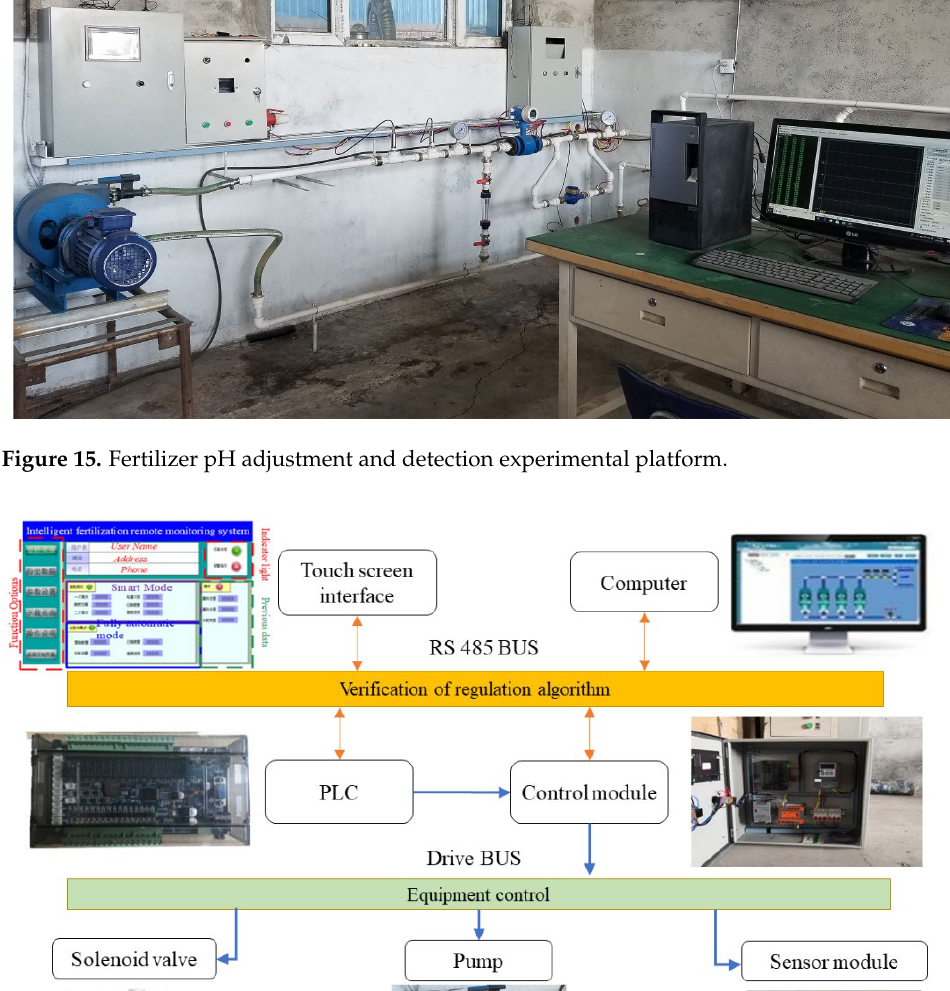
Figure 16. Structure of the fertiliser pH adjustment test system.